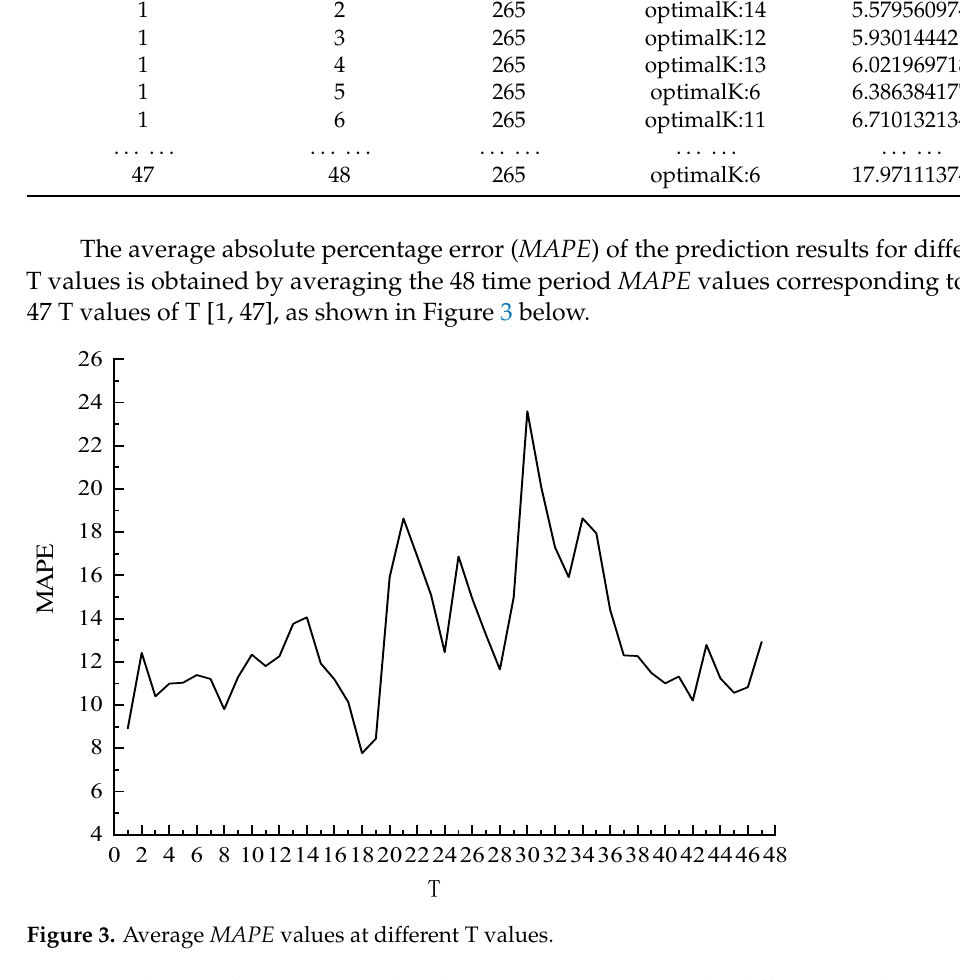
Figure 3. Average MAPE values at different T values.